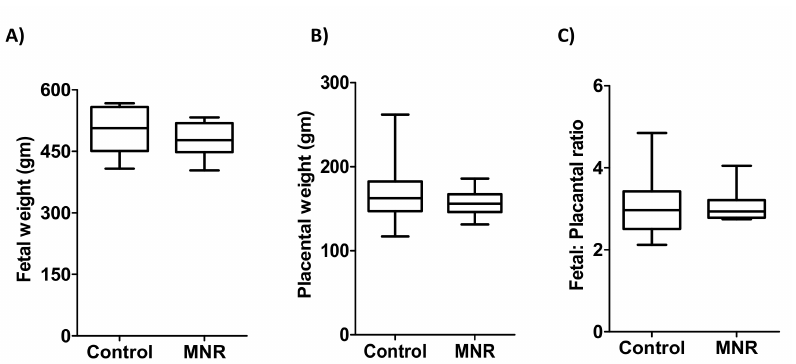
Figure 1. Fetal weight, placental weight and fetal: placental ratio of control and MNR group at GD 140. ( A ) Fetal (Birth) weight ( B ) placental weight and ( C ) fetal: placental weight ratio at gestational day 140 in the control and MNR groups. Medians ± IQR, n = 10 control; n = 12 MNR. KS normality test p value: Fetal weight (Control, p > 0.10; MNR, p > 0.10; passed normality), Placental weights (Control, p > 0.10; MNR, p > 0.10; passed normality), Fetal: Placental ratio Control, p > 0.10; MNR, p > 0.10; passed